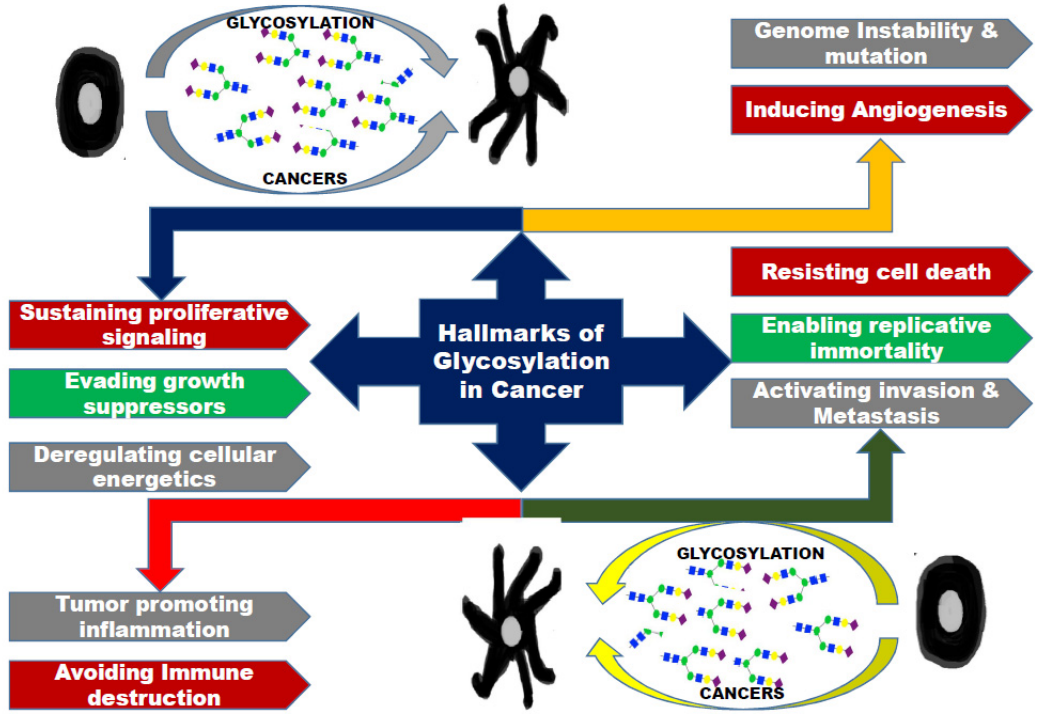
Figure 2. Snapshot of the hallmarks of glycosylation in cancer [15].